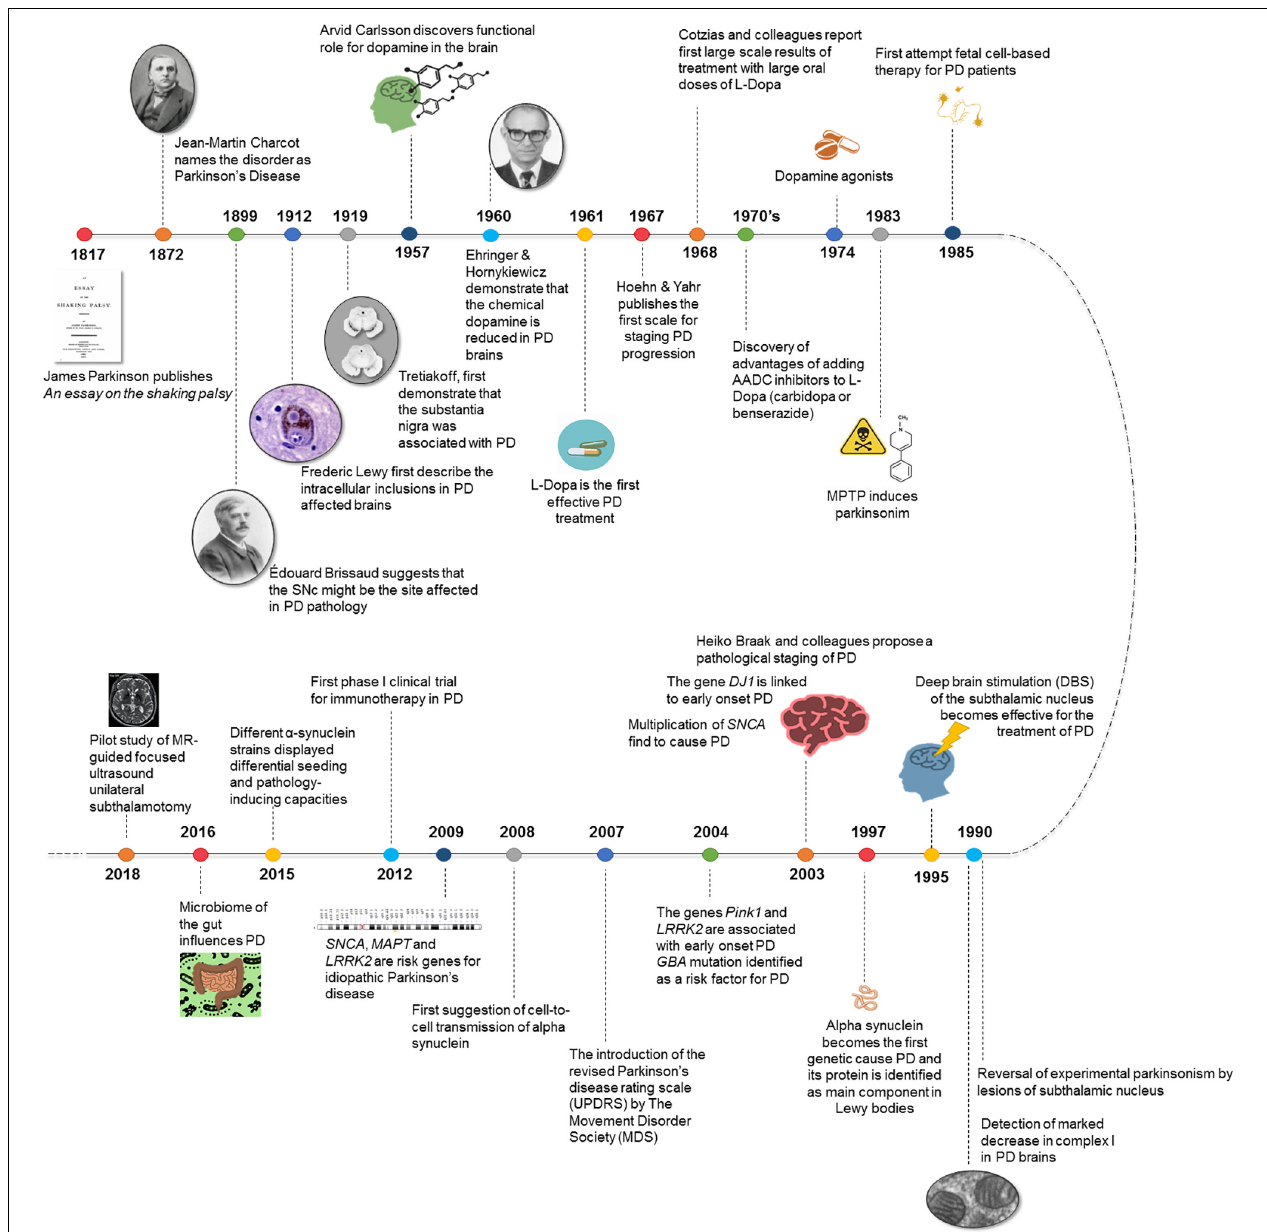
FIGURE 1 | Breakthroughs in Parkinson’s disease